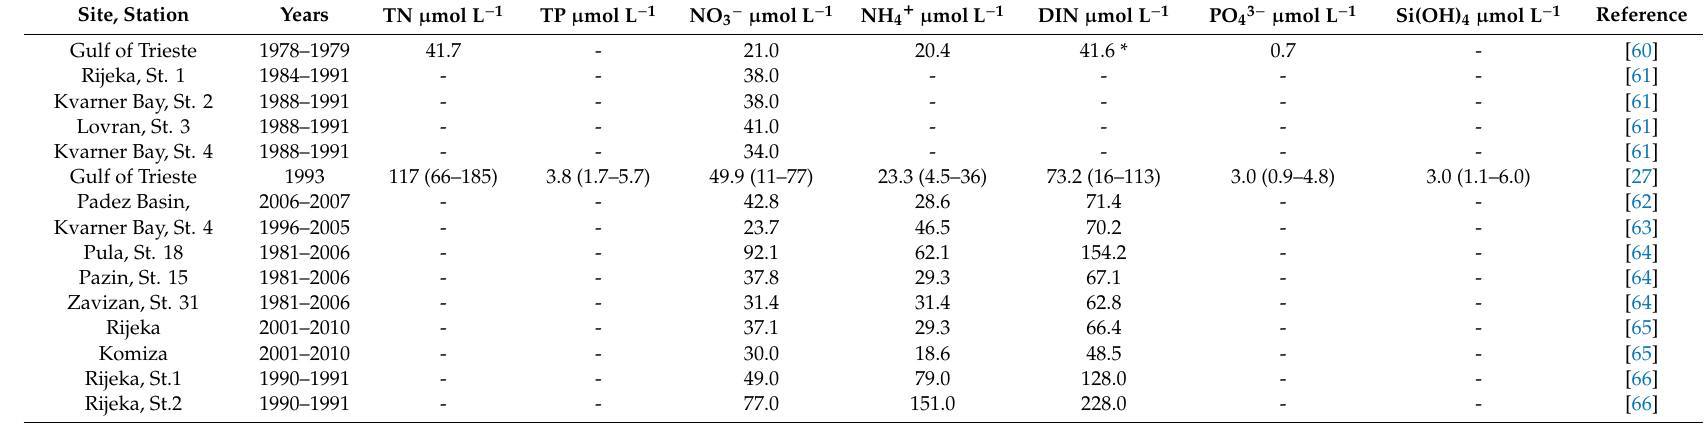
Table A2. Mean and range of the values of nutrient concentration ( µ mol L − 1 ) in the rainwater in coastal sites of the Northeastern Adriatic Sea. Notice that most of the estimates of DIN do not include NO 2 − .